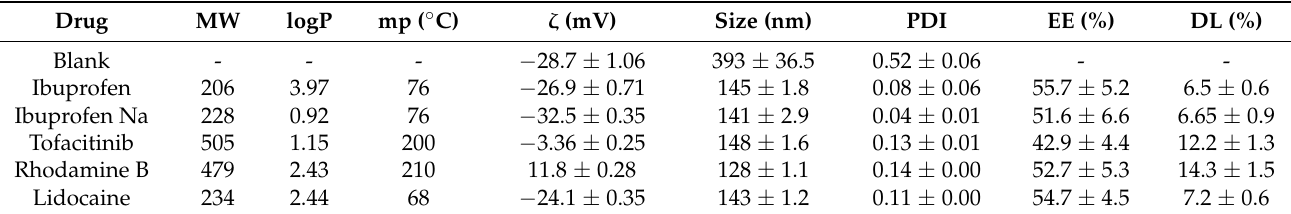
Table 1. Characteristics of proposomes containing different